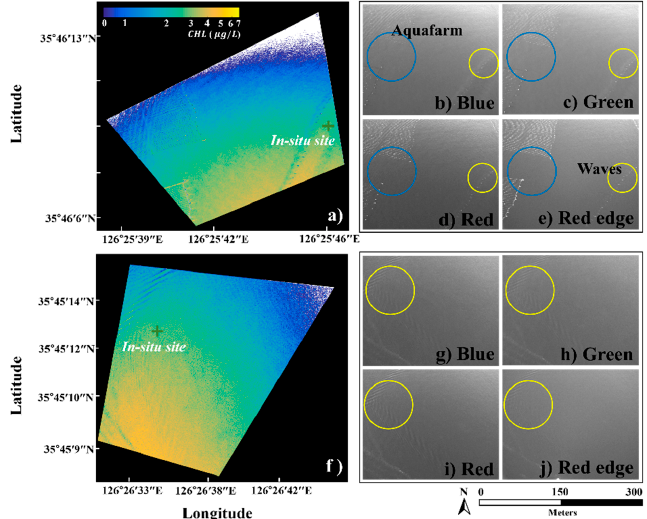
Figure 8. 2D CHL ( a ) derived from multispectral camera images ( b – e ) and another 2D CHL ( f ) derived from multispectral camera images ( g – j ) on October 25, 2018. While ( b – e ) and ( g – j ) were not georeferenced, ( a , f ) were georeferenced. The cross marks represent the in-situ site. The blue and yellow circles represent the aquafarm site and the waves features, respectively.